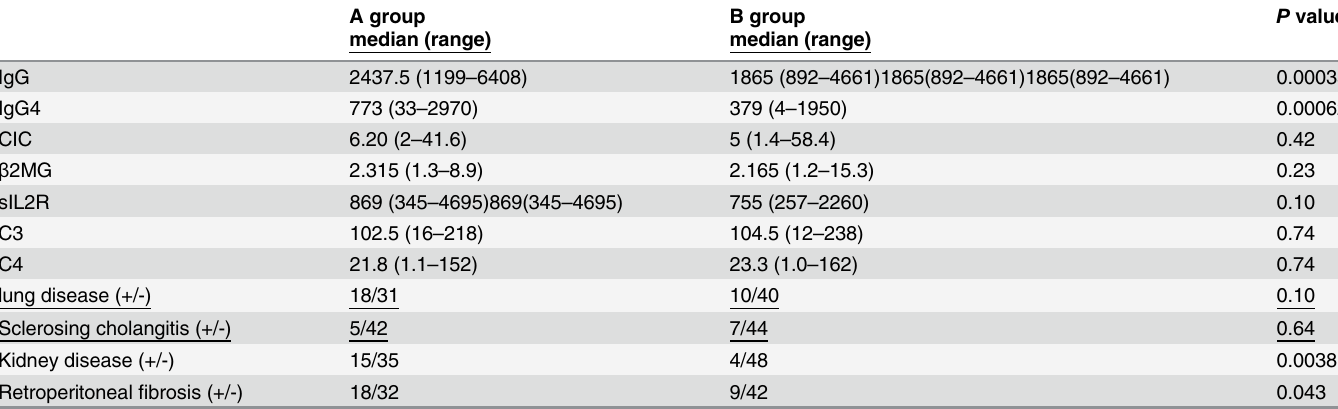
Table 2. Comparison of activity state between type 1 AIP with and without lachrymal/salivary gland